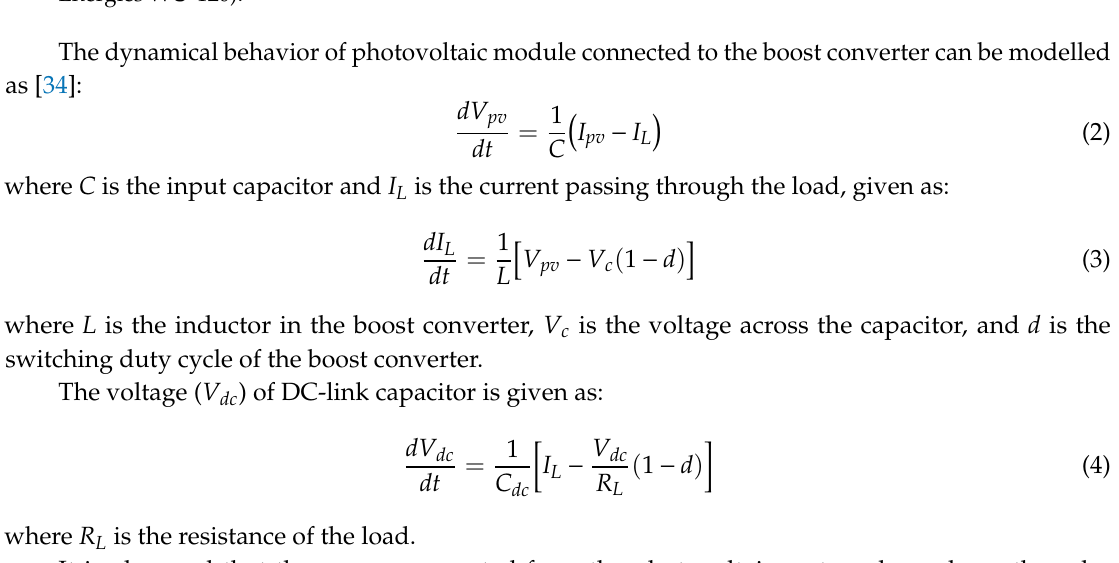
Figure 2. ( a ) Current-voltage and ( b ) power–voltage characteristics of photovoltaic module (Waaree Energies WU-120).